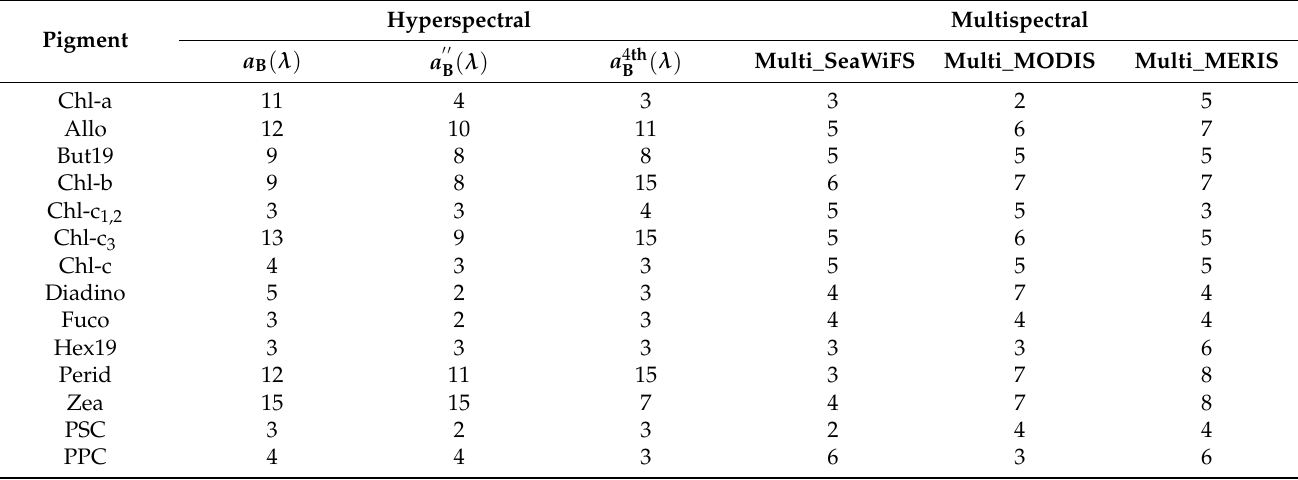
Table 6. The PCN for each pigment when different types of spectra are used, which includes a B ( λ ) , a (cid:48)(cid:48) Multi_SeaWiFS, Multi_MODIS, and